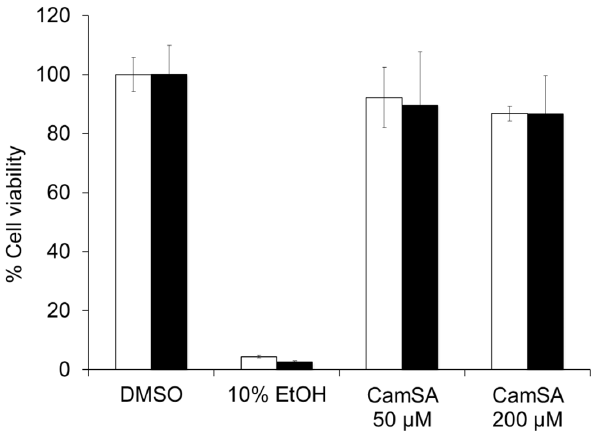
Figure 3. Cytotoxicity of CamSA. Vero cells (white bars) or Caco-2 cells (black bars) were incubated overnight with 10% DMSO, 10% EtOH, 50 m M CamSA or 200 m M CamSA. Cell viability was determined with the CellTiter Glo viability kit. The luminescence signal from DMSO-treated cells was undistinguishable from untreated cells and was set as 100% cell viability. Percent survival for other conditions was calculated relative to untreated cells. Error bars represent standard deviations from at least five independent measurements.